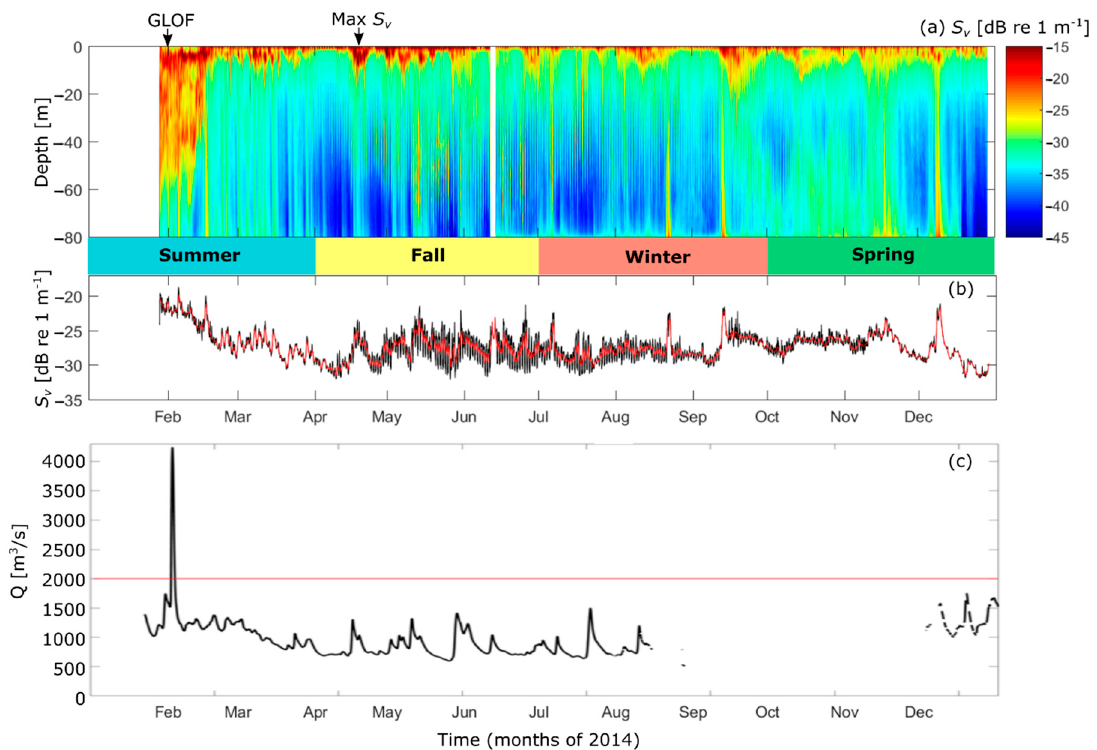
Figure 7. ( a ) Volume backscatter, S v from January to December of 2014, ( b ) the depth average of S v (black line) and the low-pass filtered (30 h), depth-averaged S v (red line), ( c ) river discharge (black line) with a discharge value of 2000 m 3 s − 1 , indicative of a GLOF, depicted by the red line.